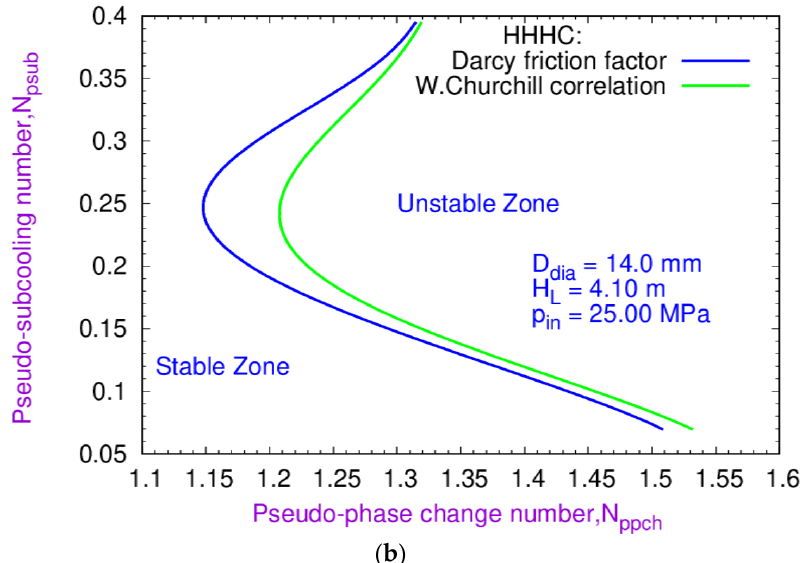
Figure 10 . Effect of the friction factor on the DWI of the loop. Figure 10. Effect of the friction factor on the DWI of the loop: ( a ) specific enthalpy vs. power; ( b ) (Nppch) vs. (Npsub)